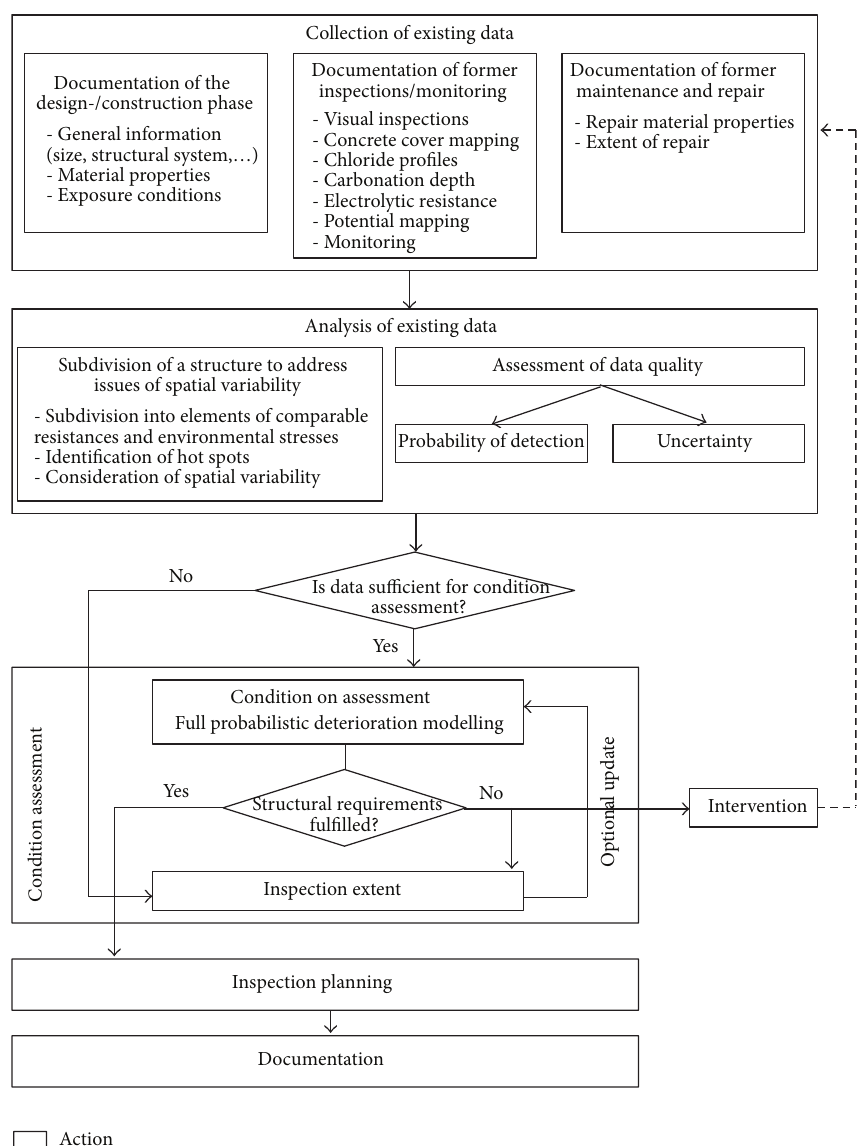
Figure 2: Flow chart for the condition assessment of existing structures (before repair)